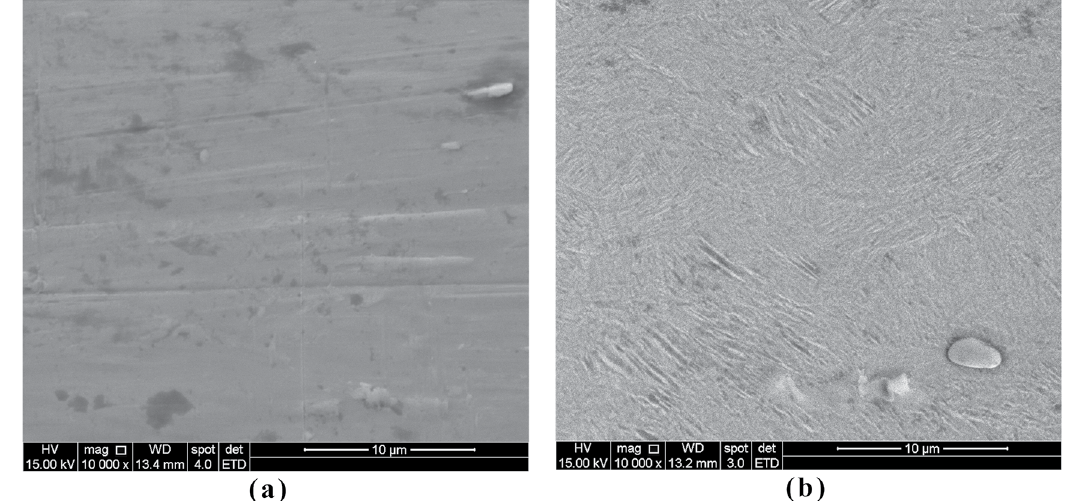
Figure 3. Surface morphology of the studied Ni-Ti wire: (a) as received; (b) after